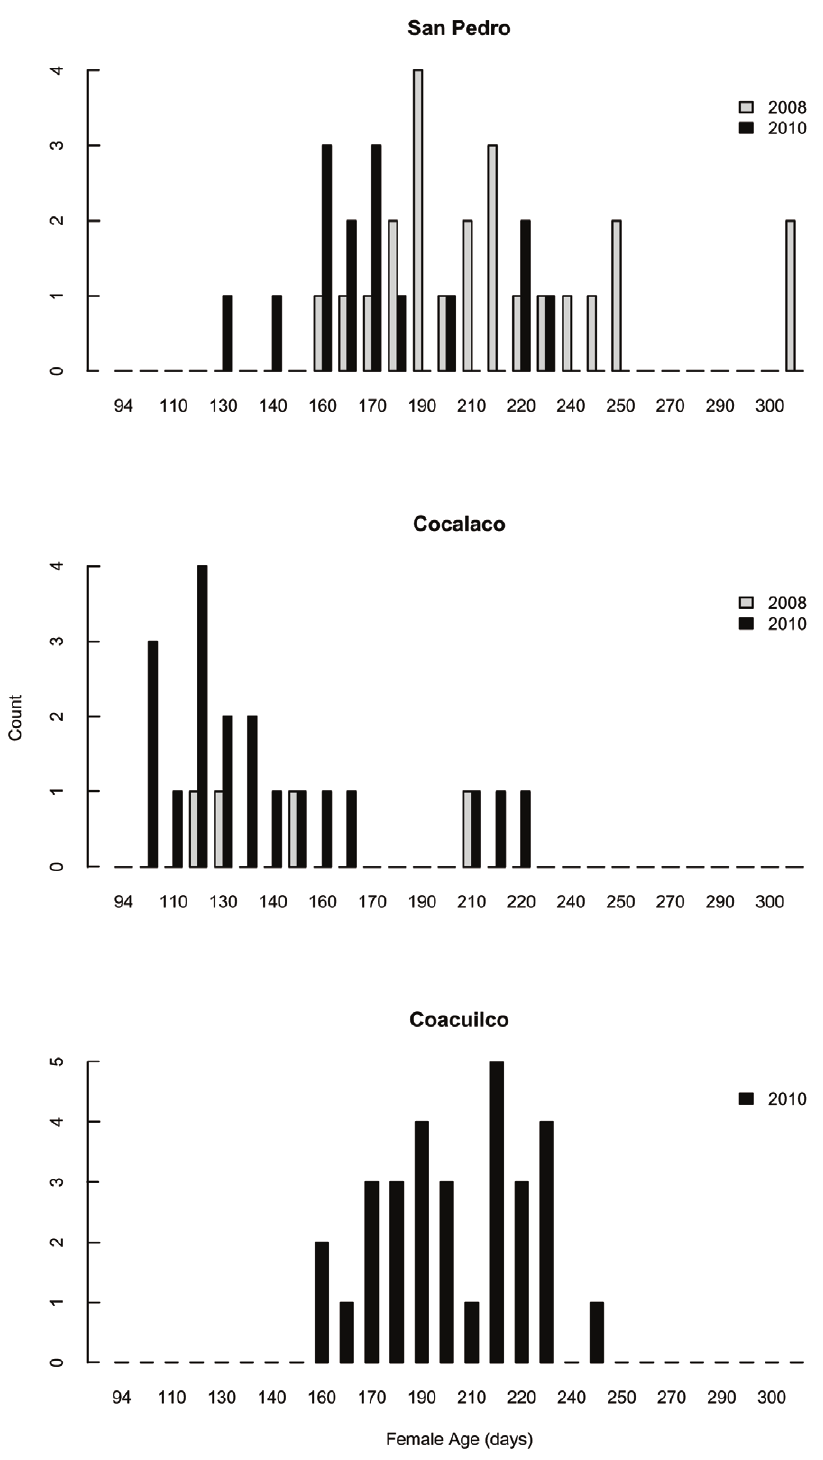
Figure 2. Site and year differences in female age (in days). Females are mature (i.e., gravid). Top panel: San Pedro. Middle panel: Cocalaco. Bottom panel: Coacuilco. In 2010 we added Coacuilco as a third site to examine females in a size range intermediate to San Pedro and